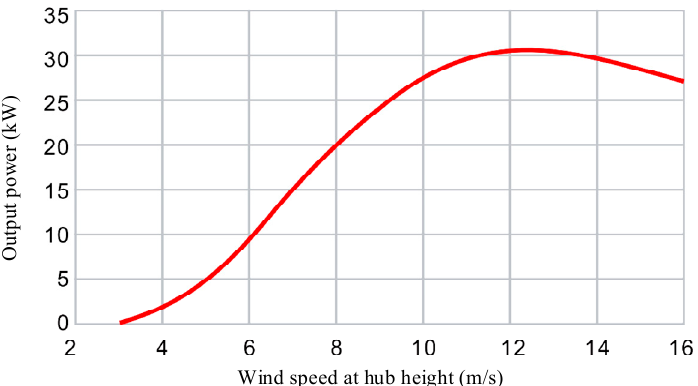
Figure 2. The power curve of FD16-30.